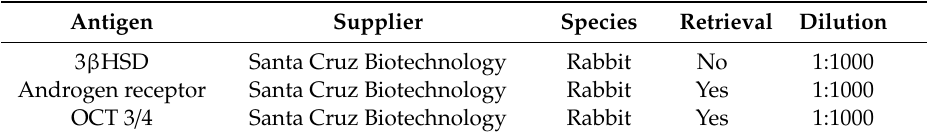
Table 1. Details of the antibodies